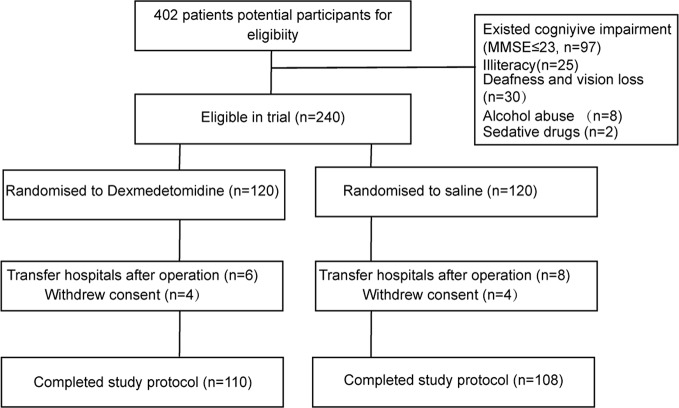
Flowchart of study inclusion, randomization, and follow-up.